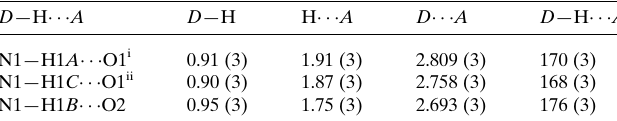
Table 1 Hydrogen-bond geometry (A˚ , (cid:5) ) for (I).